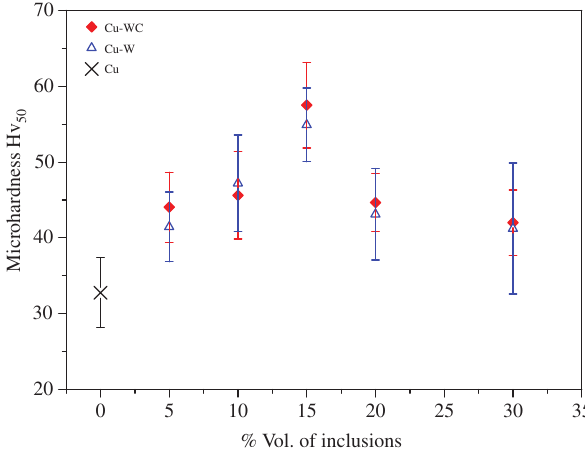
Figure 10: Hardness as a function of the volume of reinforcing parti- cles for both kinds of reinforcing particles